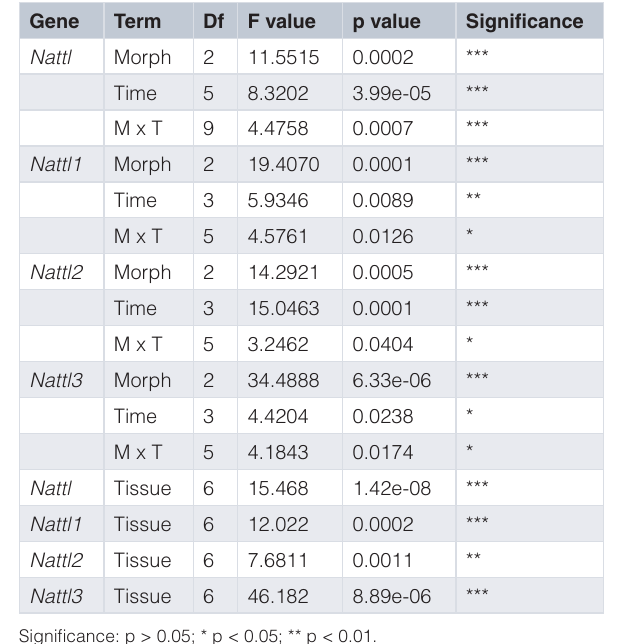
Supplemental Table S5. ANOVAs on Natterin-like qPCR on adults. Studied were levels of Natterin-like and Natterin-like